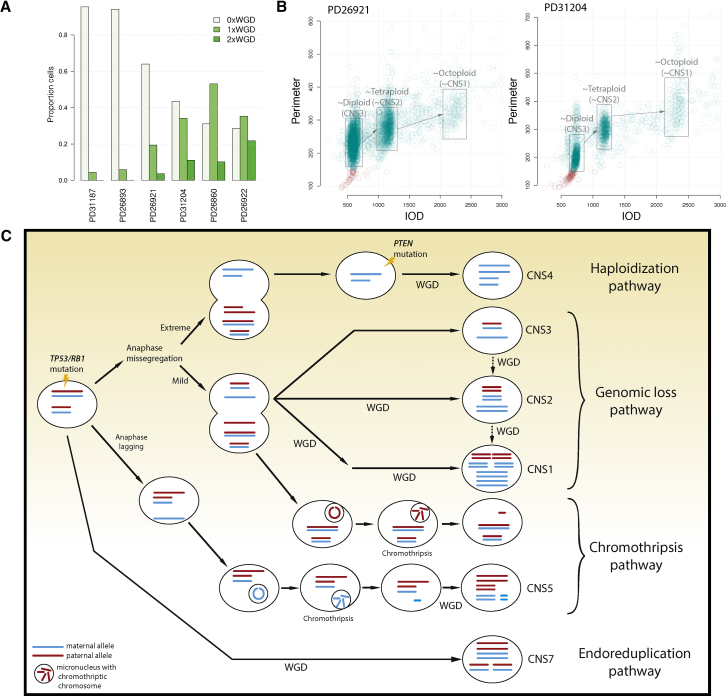
Evolutionary Pathways in USARCs(A) Proportion of cells within a sample with no WGD (0×WGD), one WGD (1×WGD), or two WGDs (2×WGD) using cytometric ploidy analysis, for six samples estimated to be non-WGD through WGS.(B) Representative examples of ploidy results for CNS3 (diploid) samples. Ploidy displayed as integrated optical density (x axis) and nuclear perimeter (y axis) of each nucleus.(C) Proposed pathways of USARC tumorigenesis. Driver mutations (TP53 and RB1) are early events in USARCs. Haploidization pathway: extreme anaphase mis-segregation associated with near-genome-wide haploidy, which is rescued by WGD, leading to a CNS4 pattern. Genomic loss pathway: less extreme anaphase mis-segregation generates large areas of LOH. Three signatures (CNS3, CNS2, and CNS1) that are variations of this LOH pattern but differentiated from each other by subsequent WGD. Chromothripsis pathway: anaphase mis-segregation or anaphase lagging could also lead to chromosomal micronucleation. CNS5 is a signature of this process followed by WGD. Endoreduplication pathway: a tumor cell may undergo WGD with relatively few other copy-number alterations: CNS7.